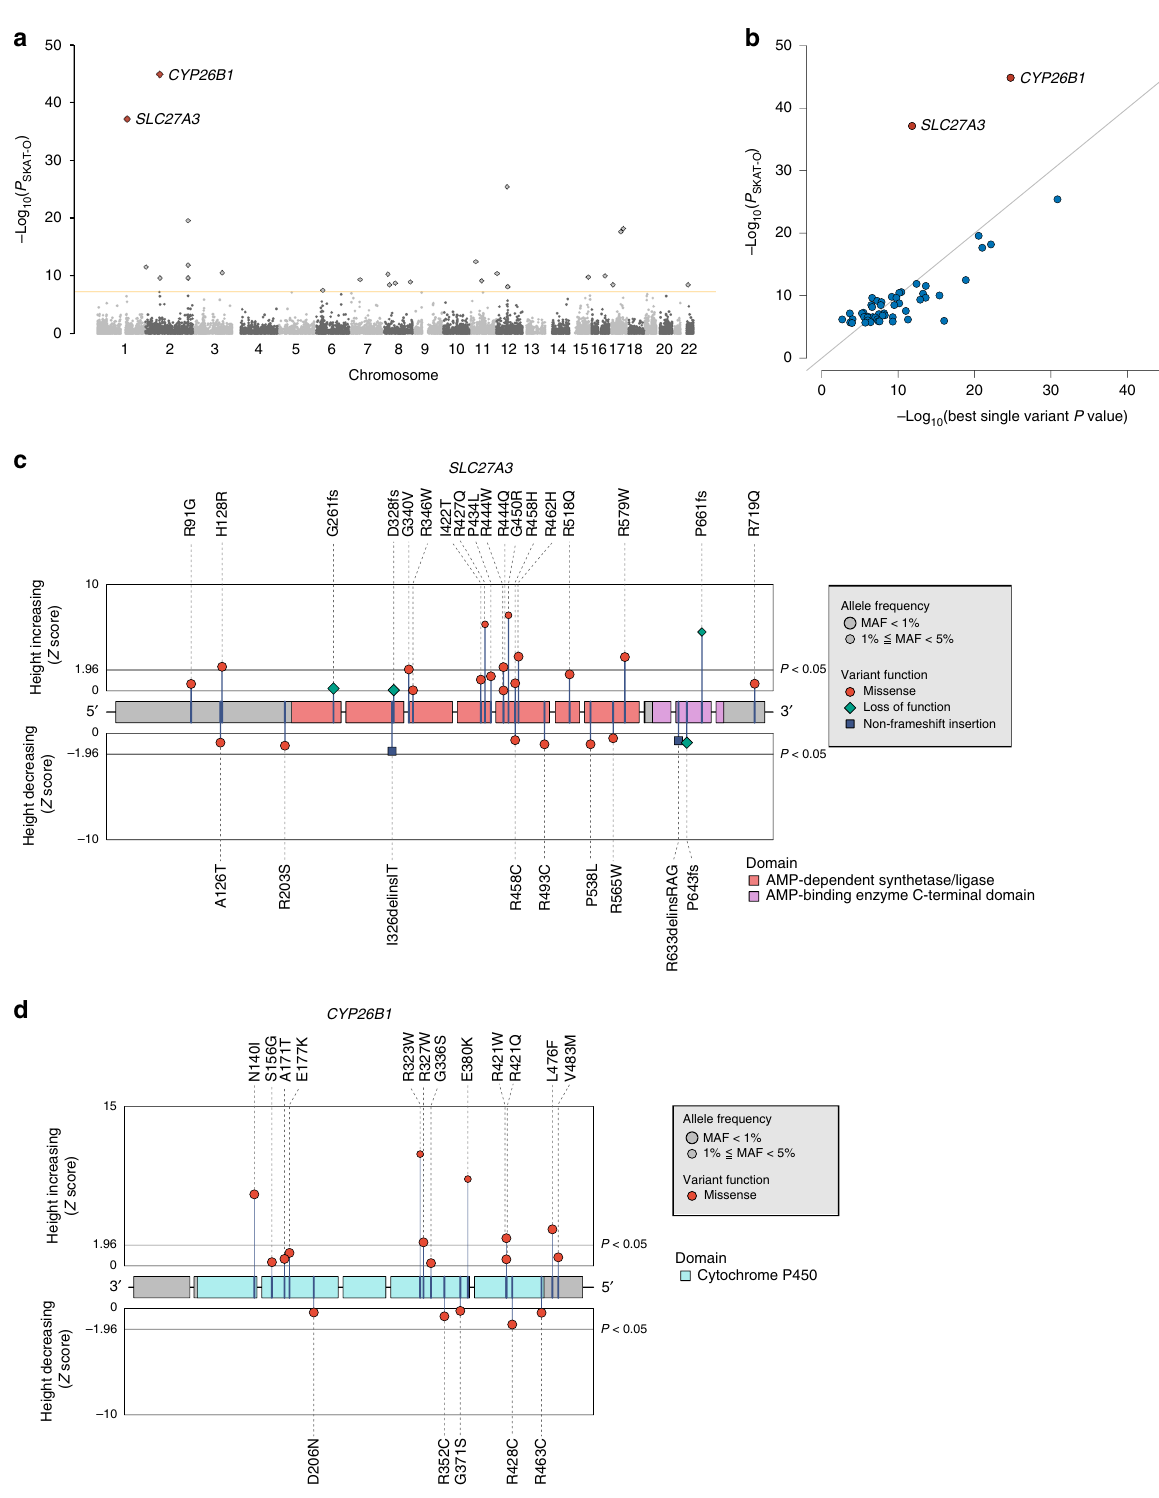
Fig. 3 Summary of gene-based analysis. a Manhattan plot of the gene-based test. The yellow line represents signi fi cance threshold ( P < 2.5 × 10 − 6 ). b Comparison of single-variant test P values and those of the gene-based test. Two genes ( SLC27A3 and CYP26B1 ) showed much stronger associations in the gene-based test. c , d Positions and associations of nonsynonymous variants in SLC27A3 and CYP26B1 . The colors of the plots denote the impact of the variants. The symbols (circle, diamond, and square) indicate the function of variants. The coding regions are colored according to their structural domains based on